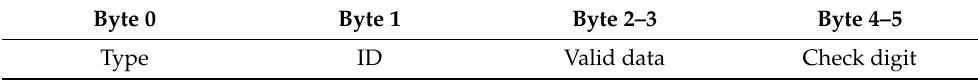
Table 6. A description of the specific meaning of each field of the Bluetooth data packet is shown in detail in Table 7. Table 6. Packet